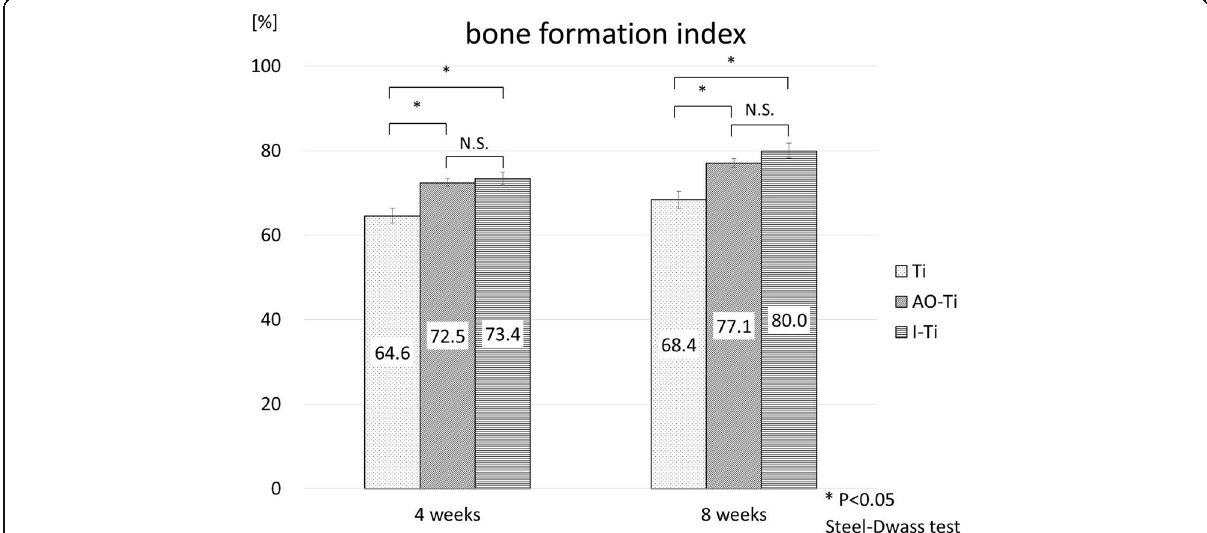
Fig. 7 Results of histological examination (bone formation index). At 4 and 8 weeks after screw insertion, bone formation index of the AO-Ti and I-Ti groups was significantly higher than that of the Ti group (p < 0.05). There was no significant difference found between the AO-Ti and I-Ti